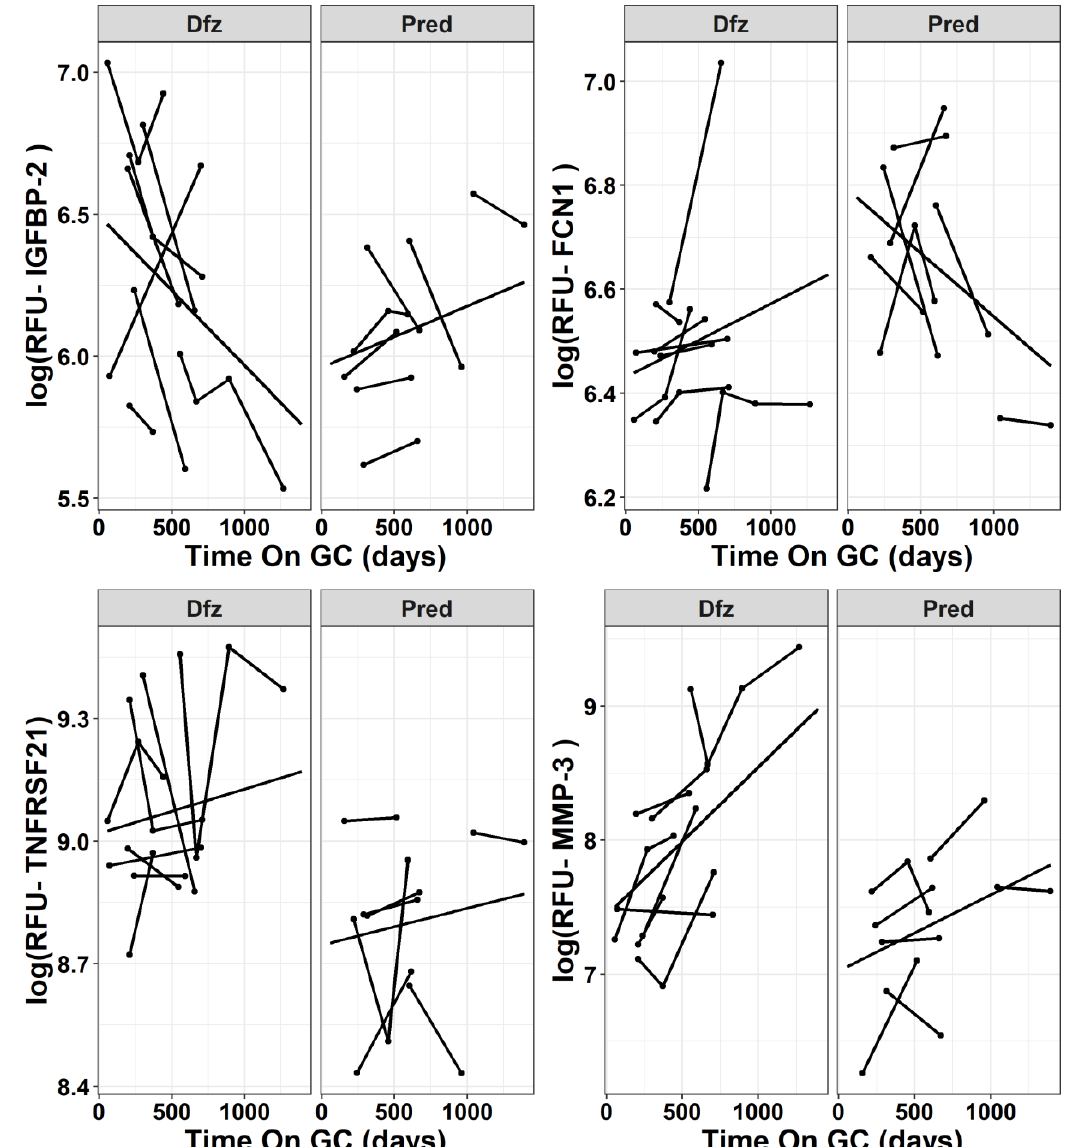
Figure 3. Selected examples of serum protein PD biomarkers showing difference between prednisone (Pred) and deflazacort (Dfz)-treated samples. FCN-1 has relatively higher mean RFU levels in Dfz- treated patients ( p = 0.038 for mean levels; p = 0.03 for difference in trajectory slopes over time). TNFRSF21 has higher mean RFU levels in Pred- vs. Dfz-treated DMD patients ( p = 0.005 mean levels; p = 0.934 for difference in trajectory slopes over time). The longitudinal trajectories of IGFBP-2 levels are different between the two drugs ( p = 0.04). MMP-3 mean RFU level is elevated in DMD boys treated with Dfz, as compared to Pred ( p = 0.008).